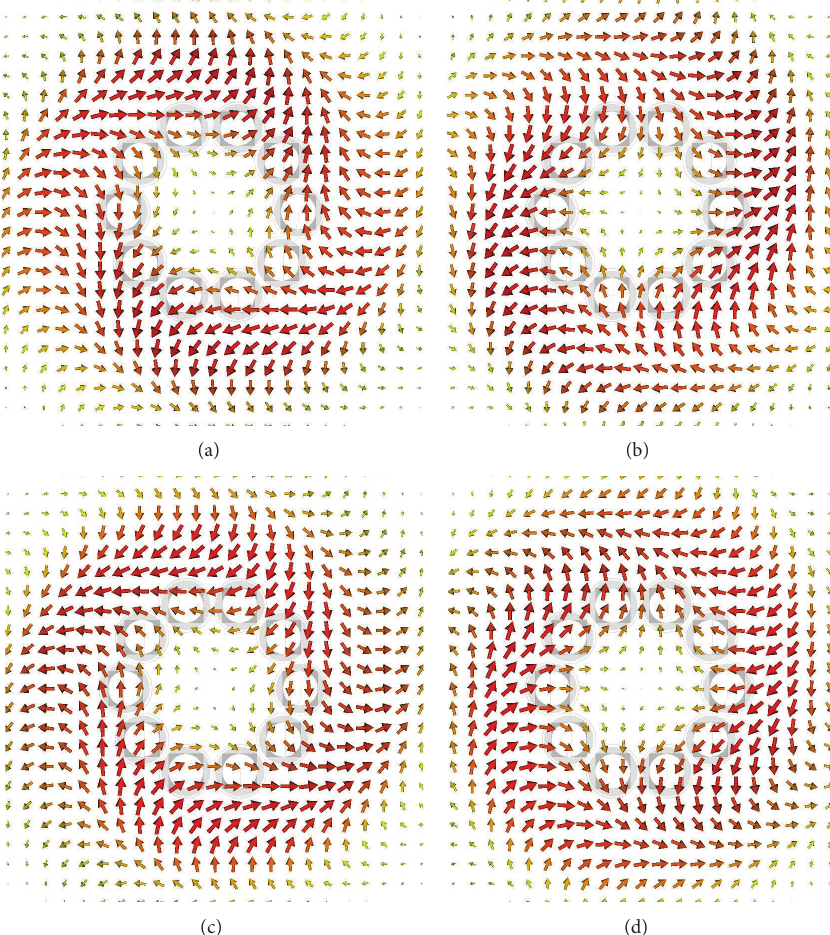
Figure 11: Electric field vectors with state ℓ = +1 for left circular polarization in one period: (a) phase = 0 ∘ , (b) phase = 90 ∘ , (c) phase = 180 ∘ , and (d) phase = 270 ∘